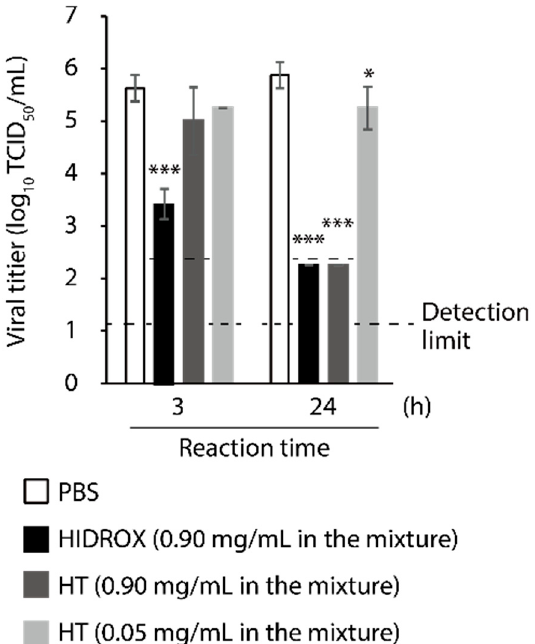
Figure 2. Comparison of virucidal activity of hydroxytyrosol (HT)-rich aqueous olive pulp extract (HIDROX) and HT against severe acute respiratory syndrome coronavirus 2 (SARS-CoV-2). SARS- CoV-2 was mixed with HIDROX or HT. The final concentrations of HIDROX and HT in the mixture were 0.90 mg/mL, and 0.05 and 0.90 mg/mL, respectively. PBS was mixed with the viral suspension as the diluent control. The mixtures were incubated at 25 °C for 3 or 24 h, and then the viral titers were evaluated. The detection limits of viral titer are 1.25 log 10 50% tissue culture infective dose (TCID 50 )/mL in the PBS and HT (0.05 mg/mL) groups and 2.25 log 10 TCID 50 /mL in the HIDROX (0.9 mg/mL) and HT (0.90 mg/mL) groups. Results are indicated as mean ± SD ( n = 4 per group). Student’s t -test was performed to evaluate the statistically significant difference between the PBS group and each test group; * p < 0.05; *** p <